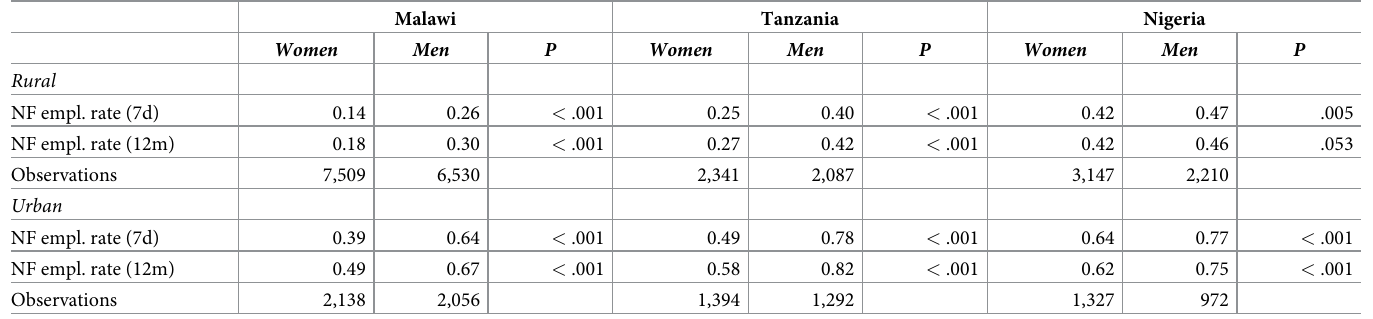
Table 1. Non-farm employment rates for population aged 25–55 in Malawi, Tanzania and Nigeria. Malawi Tanzania Nigeria Women Men P Women Men P Women Men P